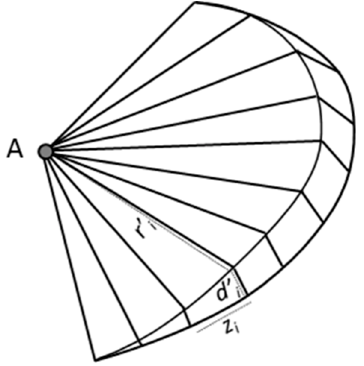
Figure 5. Input geometry for the 3D computer model of the sediment wedge.